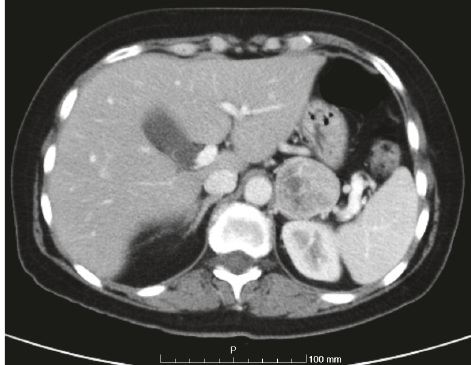
Figure 1: Adrenaltumor on abdominal CT scan . Adrenal tumor with 4.2cm length and heterogeneous iodine contrast uptake.